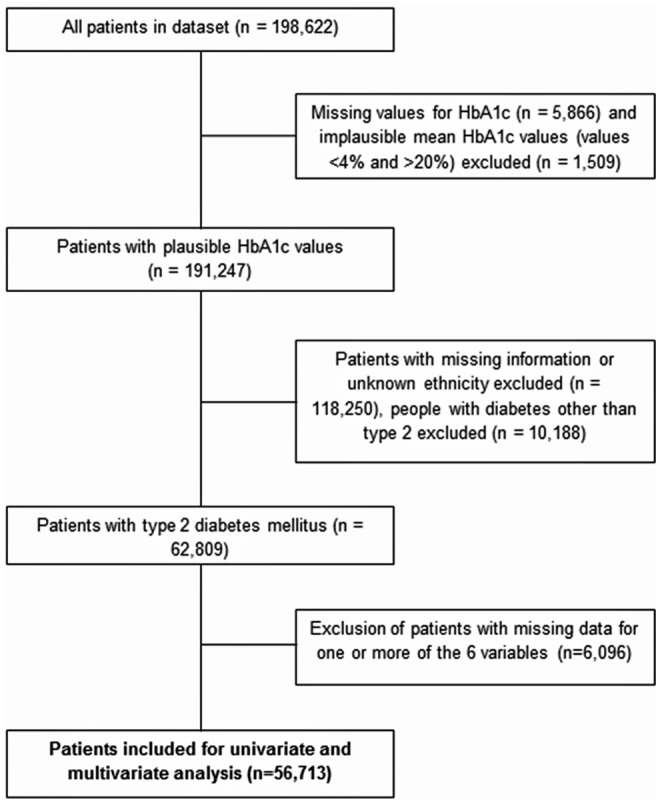
Flow chart showing inclusion and exclusion of cases for analysis.